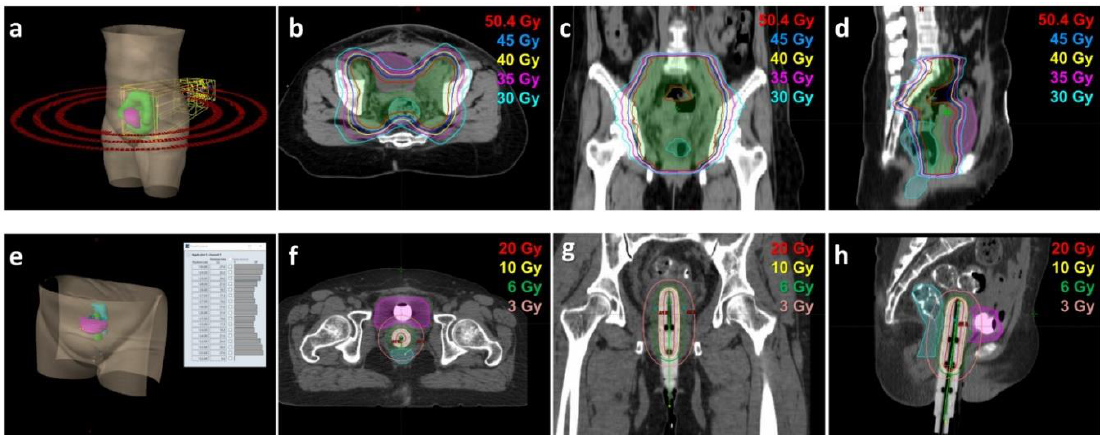
Figure 1. Modern radiotherapy techniques and dose distributions. Upper panels: isodose distributions in a patient with stage IB grade 3 endometrial cancer who underwent adjuvant radiotherapy via volumetric modulated arc therapy (VMAT). A 50.4-Gy dose (28 fractions) was prescribed to target volumes. ( a ) Beam arrangement according to VMAT plan. Dose distributions in the axial ( b ), coronal ( c ), and sagittal ( d ) views. Green, pink, and cyan areas indicate target volumes, bladder, and rectum, respectively. Red, blue, yellow, pink, and indigo lines represent isodose curves of 50.4, 45, 40, 35, and 30 Gy, respectively. Lower panels: isodose distributions in a patient with stage IB grade-1 endometrial cancer who underwent adjuvant image-guided high-dose-rate vaginal brachytherapy. A 30-Gy dose (3 fractions) was prescribed to the vaginal stump and the upper two-thirds of the mucosa. ( e ) Brachytherapy dose delivered using the “Nucletron HDR” 192 Ir remote afterloading technique. Dose distributions in the axial ( f ), coronal ( g ), and sagittal ( h ) views. Green, pink, and cyan areas indicate target volumes, bladder, and rectum, respectively. Red, yellow, green, and coral lines represent isodose curves of 20, 10, 6, and 3 Gy,